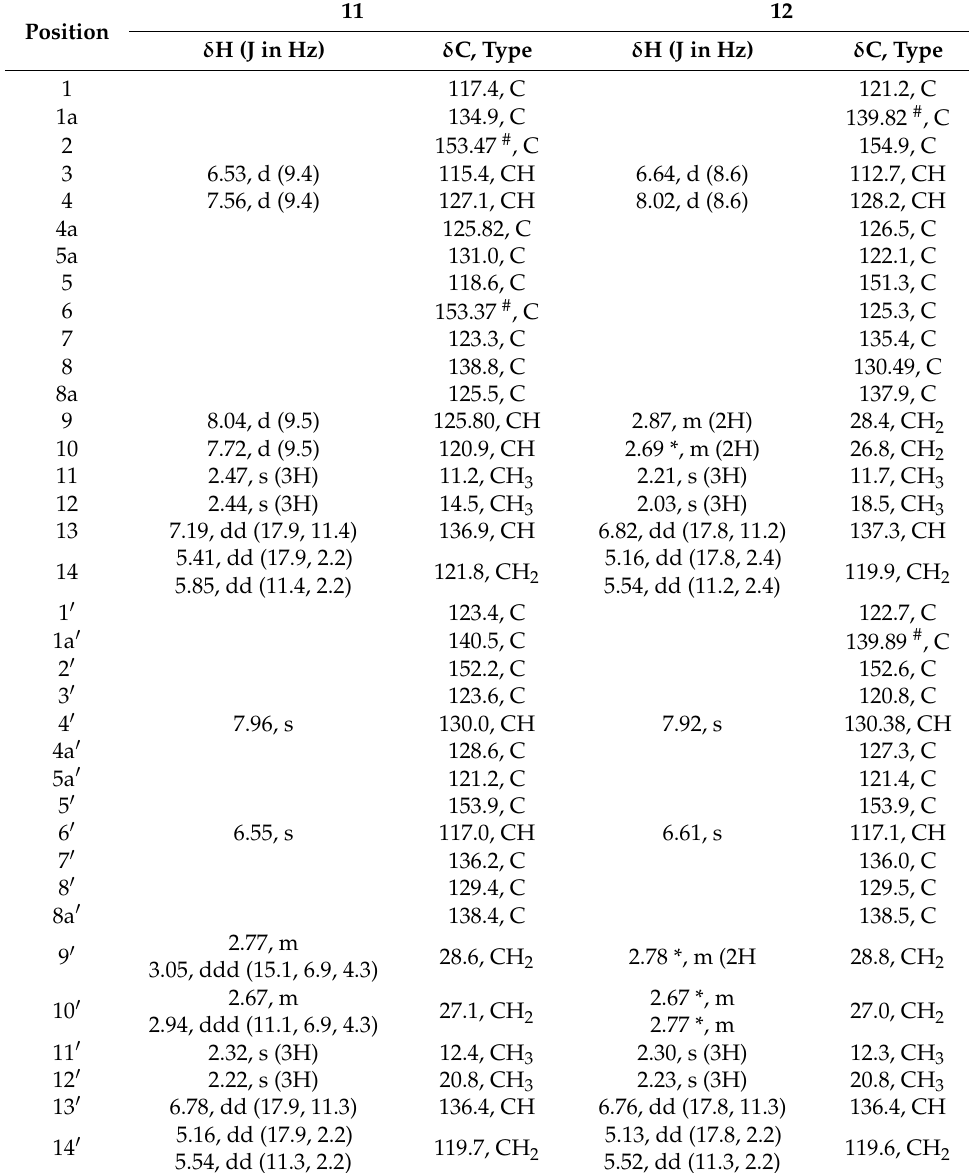
Table 5. 1 H (500 MHz) and 13 C (125 MHz) NMR data of compounds 11 and 12 in methanol- d 4